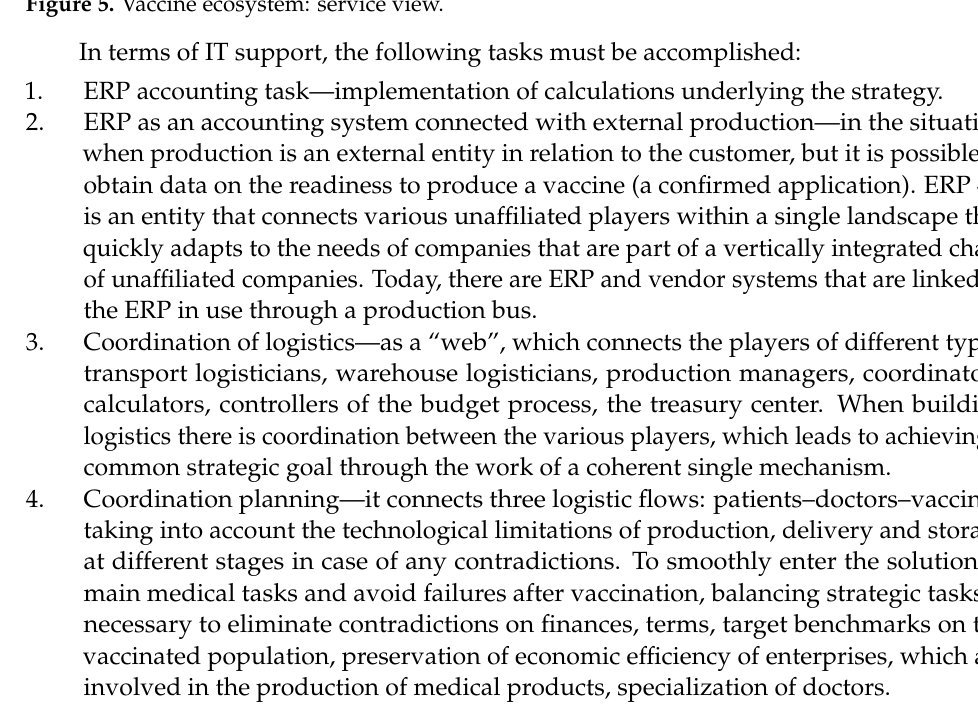
Figure 5. Vaccine ecosystem: service